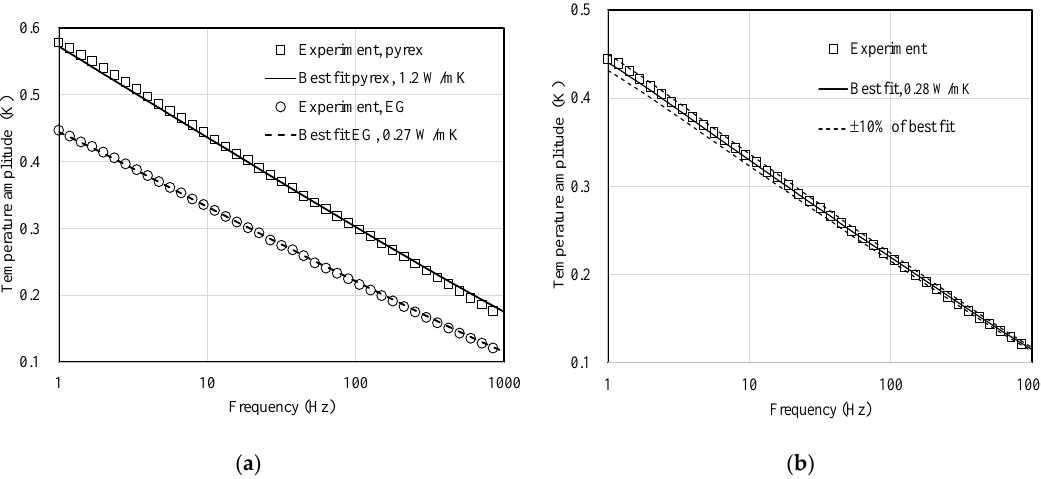
Figure 3. Measurement results for temperature amplitudes based on frequency for ( a ) the Pyrex substrate and pure EG with best fit values, and ( b ) 0.3% volume fraction multi-walled carbon nanotube (MWCNT) nanofluid with best fit and ± 10% best fit